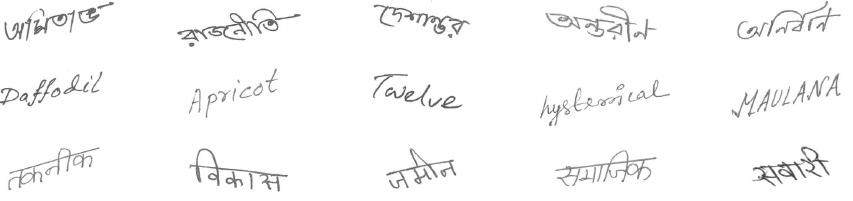
Figure 9: Sample Word Images Taken from Our Three Benchmark